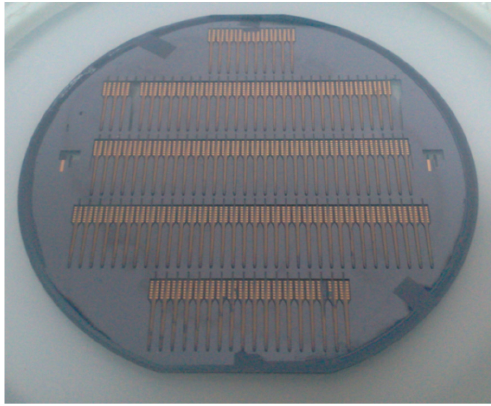
Figure 4. Picture of the entire wafer with 120 microelectrode array in holder frames.